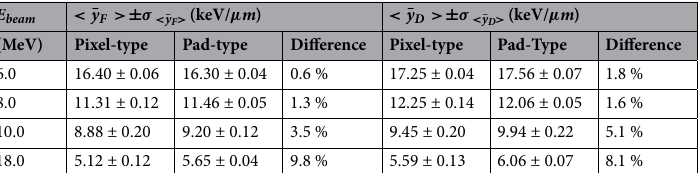
Table 1. Values of < ¯ y F > , σ < ¯ y